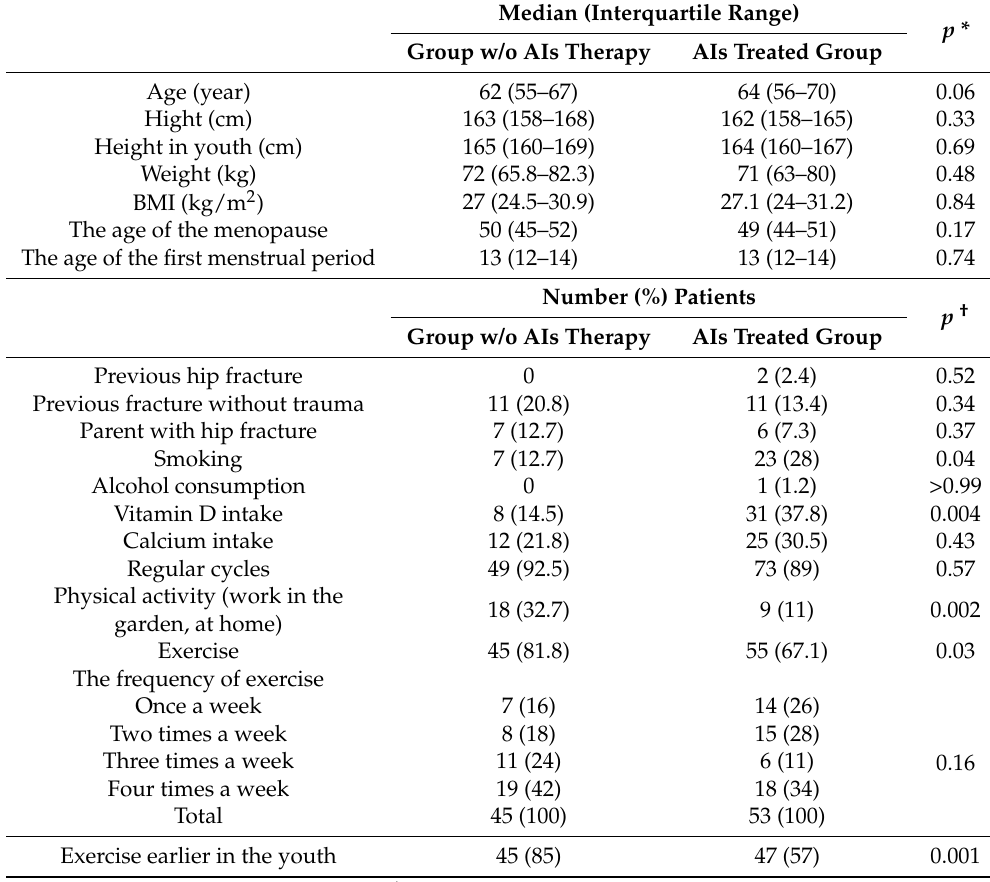
Table 1. Baseline patient